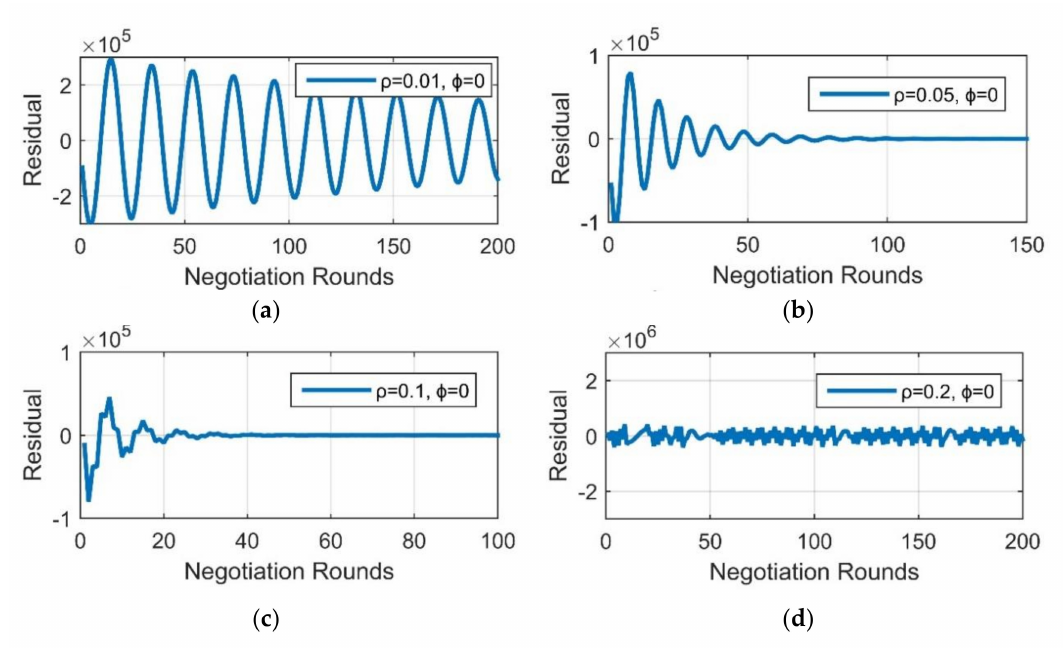
Figure 6. The negotiation process with di ff erent values of penalty factor ρ . Sub-figure ( a ) shows a very slow convergence rate with ρ = 0.01, Sub-figure ( b , c ) show faster convergence within the range 0.05 ≤ ρ ≤ 0.1, but ( c ) demonstrates an even better convergence rate. Sub-figure ( d ) show negotiation does not converge when ρ increases and reaches 0.2.